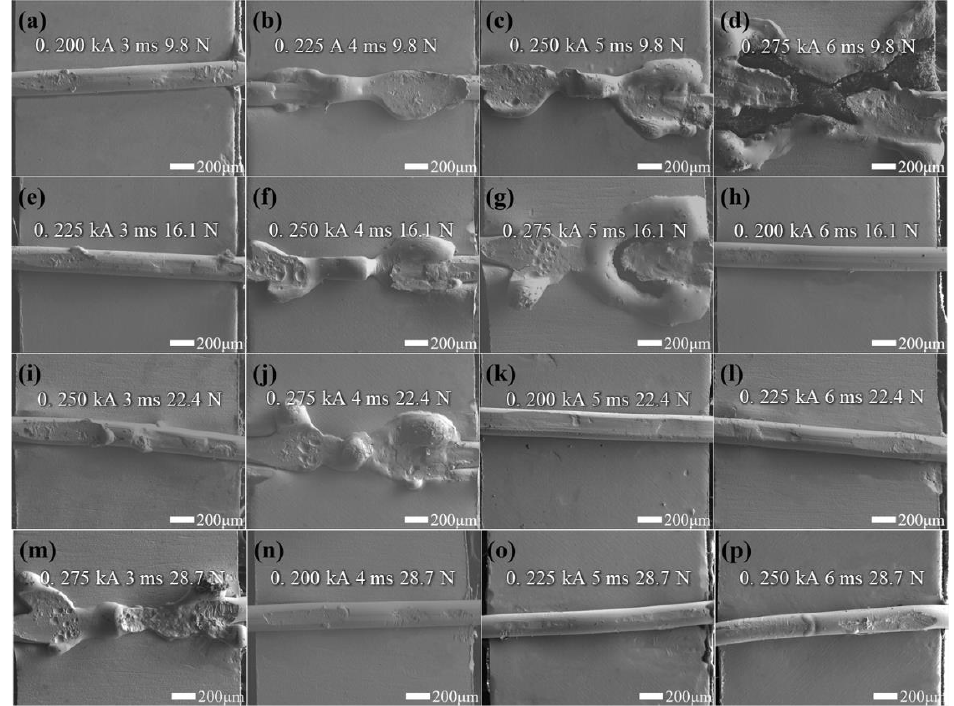
Figure 5. View of welded joints based on the parameters in Table